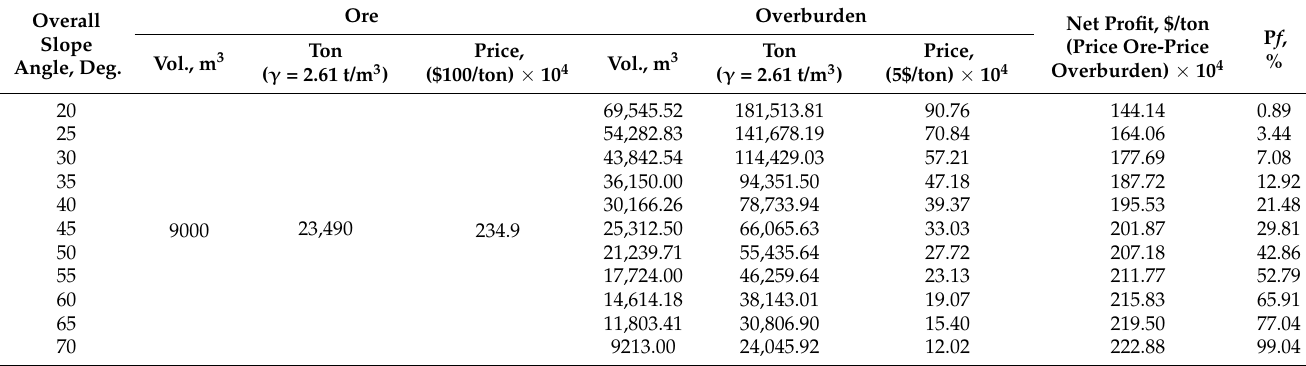
Table 4. The value of mineral extracted and the corresponding overburden to be